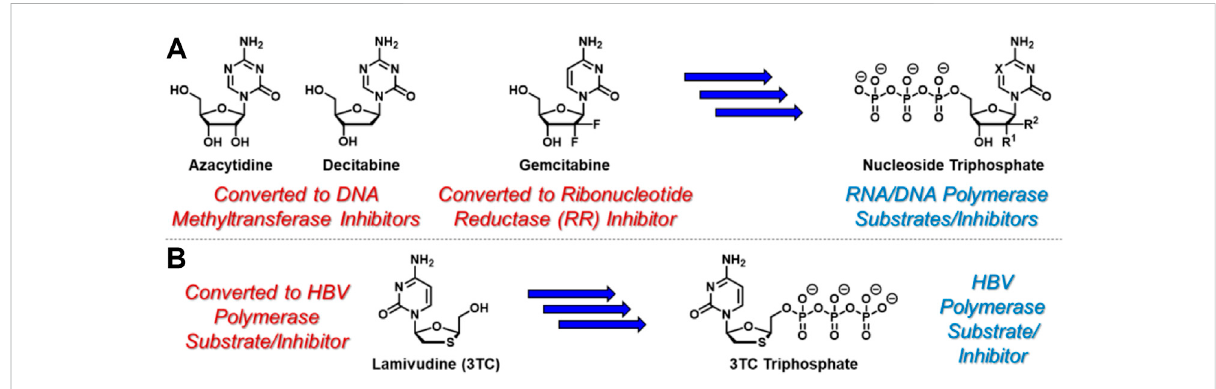
FIGURE 1 Selected anticancer nucleoside and nucleotide therapeutics and corresponding pleotropic mechanisms of action. (A) Azacytidine, decitabine, and gemcitabine are metabolically converted to the corresponding triphosphates which similarly incorporate into newly synthesized oligonucleotides. In addition, incorporated azacytidine and decitabine nucleotides inhibit DNA methyltransferases, while gemcitabine diphosphate inhibits ribonucleotide reductase. (B) Antiviral nucleoside-based therapeutic 3 TC is converted to its corresponding triphosphate, which is a suicide substrate for HBV